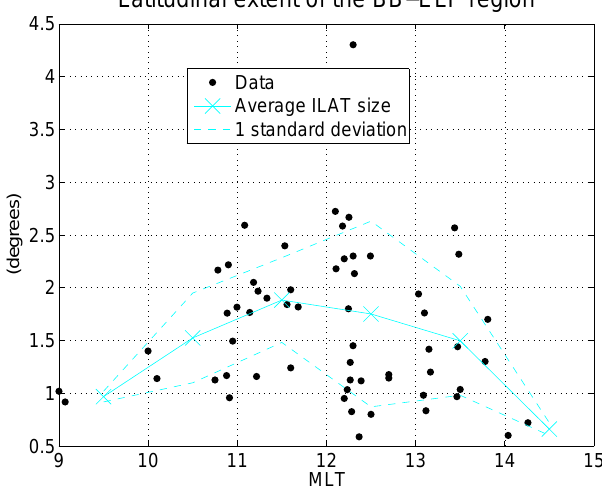
Fig. 5. The latitudinal extent of the BB-ELF region as a function of MLT. The solid line shows the average value for each 1-h bin, with ± one standard deviation shown by the dashed line. There is a clear tendency towards a broader region around noon, but with a large variation in latitudinal extent from case to case.